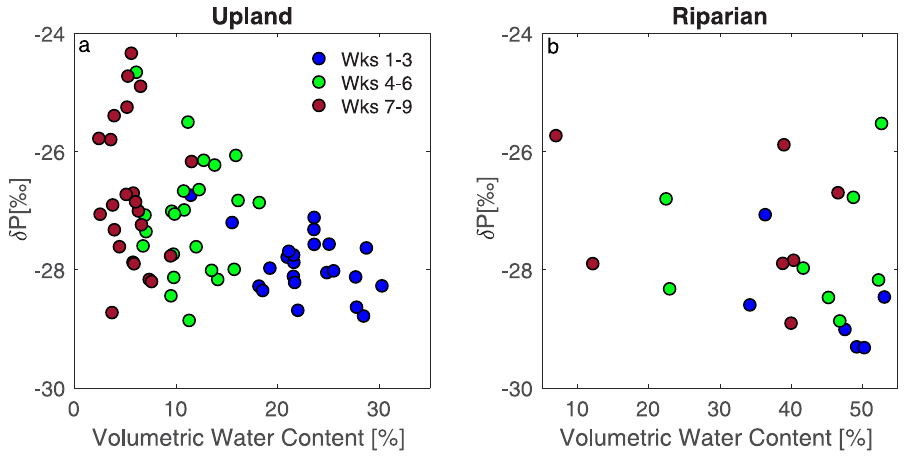
Fig 4. Volumetric water content and the δ 13 C of soil CO 2 production ( δ P ). Volumetric water content was a significant predictor of the variability of δ P across upland (R 2 = 0.23, p < 0.0001) and riparian plots (R 2 = 0.18, p < 0.05). Note x-axis range is different in each